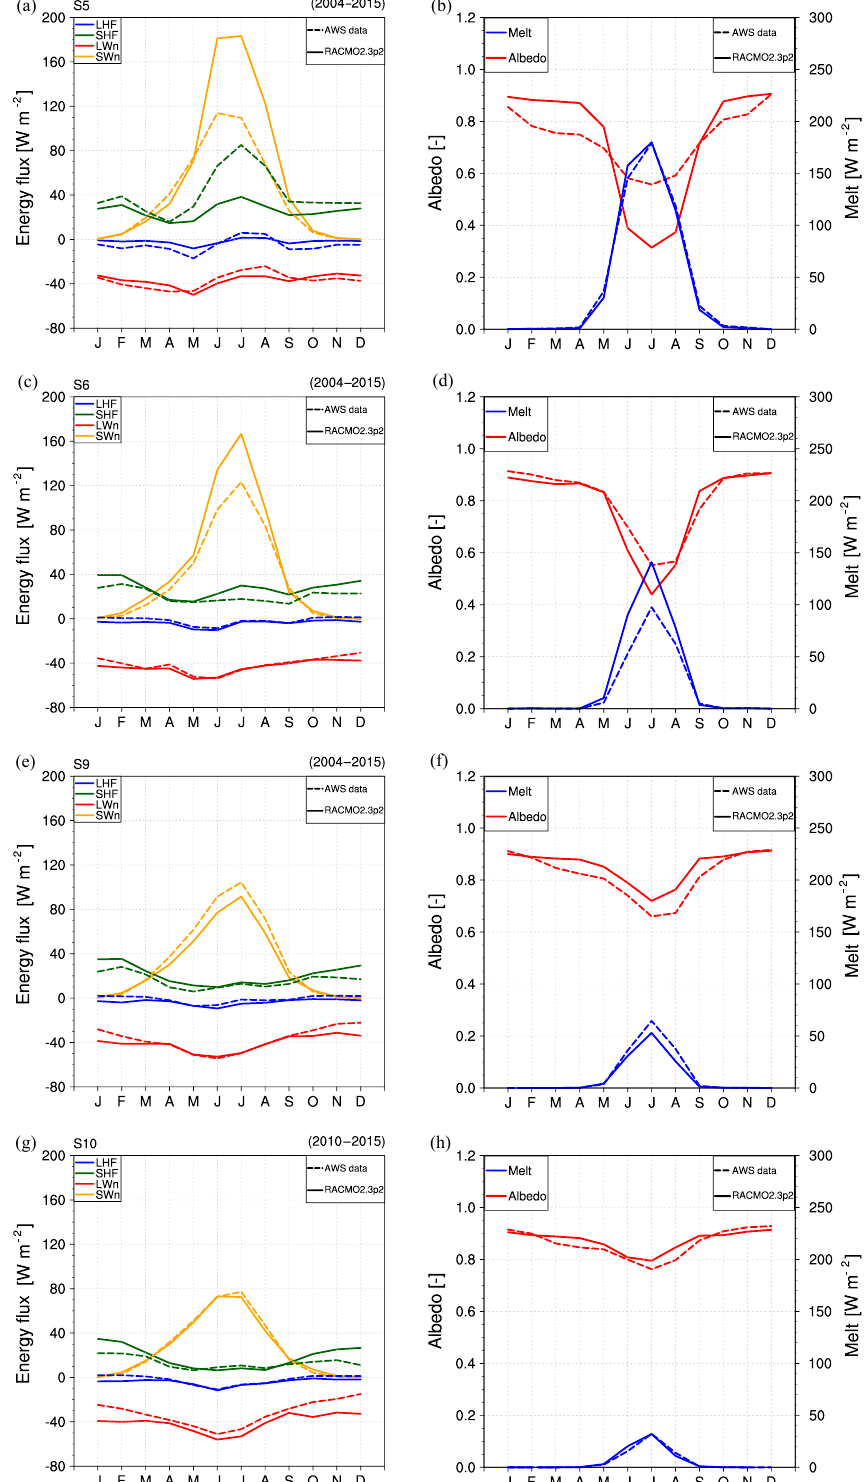
Figure 5. Observed and modelled (RACMO2.3p2) monthly mean (a) turbulent and net shortwave/longwave fluxes (Wm − 2 ) and (b) surface albedo and surface melt energy (Wm − 2 ) at site S5 for 2004–2015. Similar results are shown at S6 for 2004–2015 (c, d) , S9 for 2009– 2015 (e, f) and S10 for 2010–2015 (g, h)